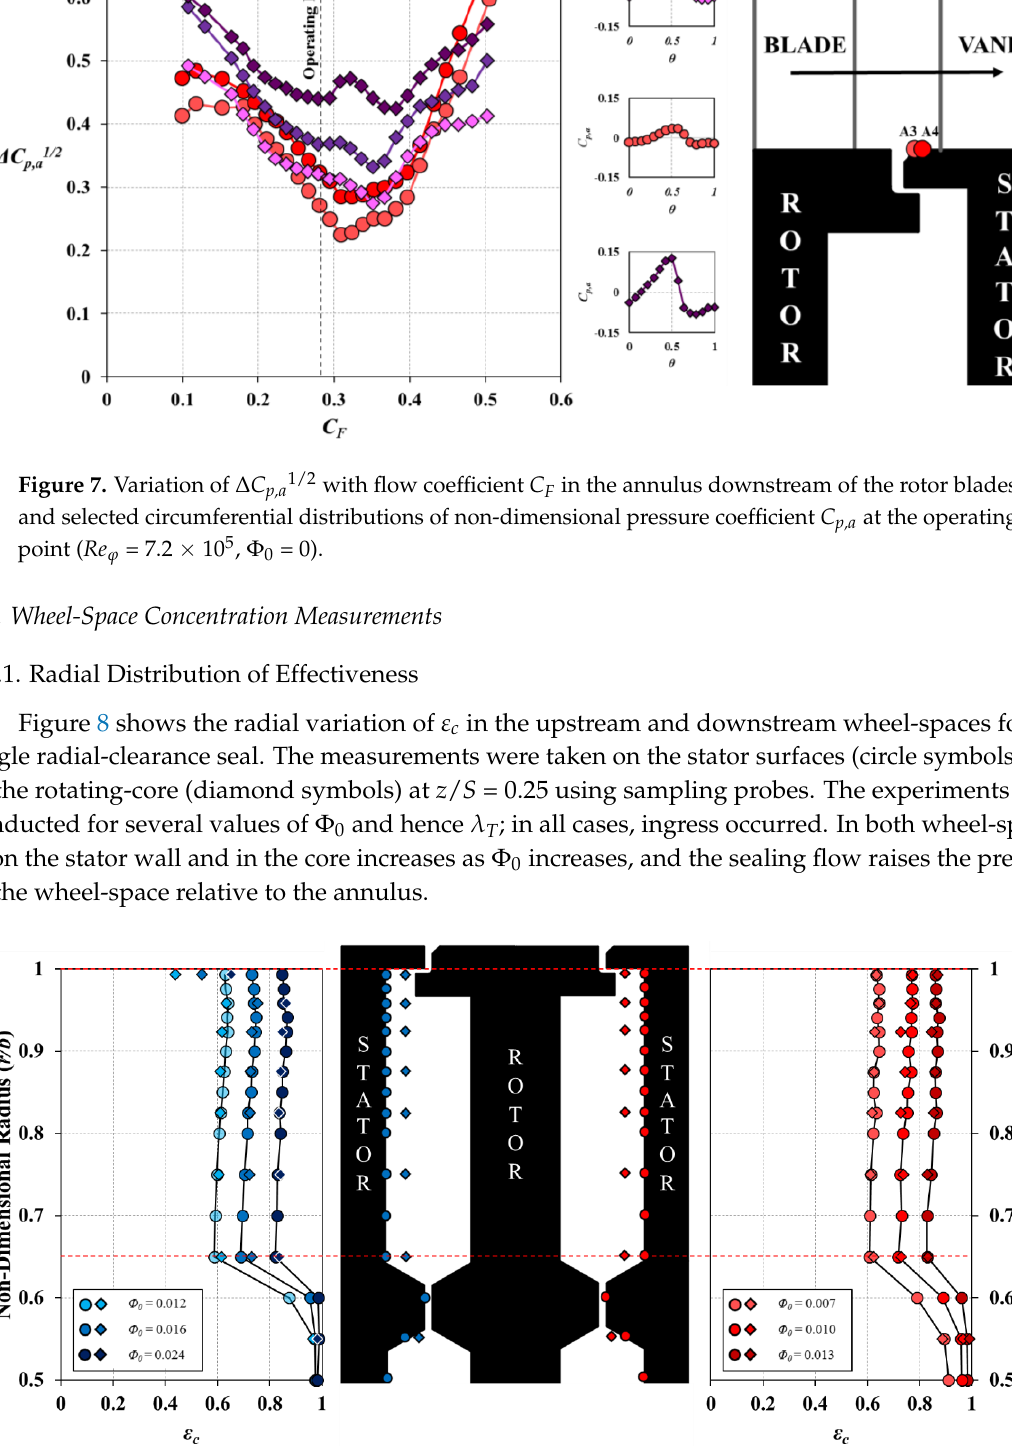
Figure 8. Effect of sealing flow rate on radial distribution of effectiveness for the single radial-clearance seal in the upstream ( left ) and downstream ( right ) wheel-space—circles: stator-wall measurements; diamonds: rotating-core measurements ( Re φ = 7.2 × 10 5 , C F = 0.29).